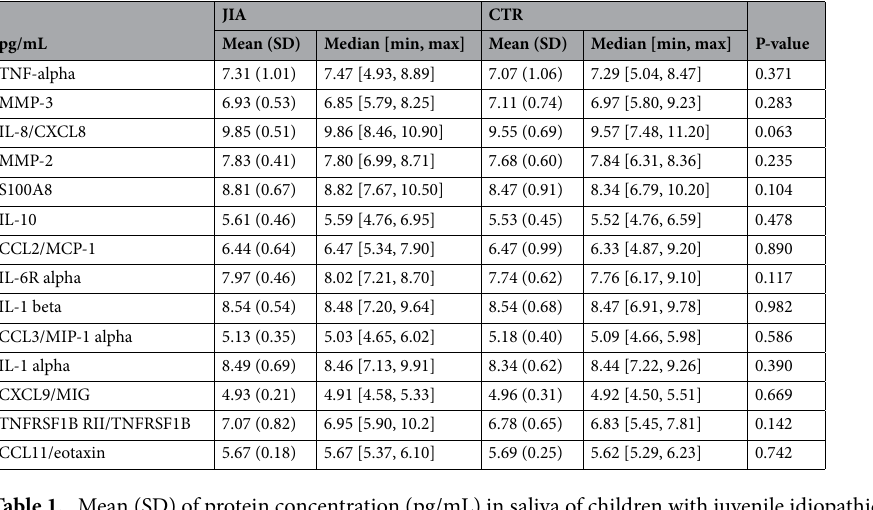
Table 1. Mean (SD) of protein concentration (pg/mL) in saliva of children with juvenile idiopathic arthritis (JIA) and healthy controls (CTR). No association was observed in the linear regression model with adjustment for age and gender (unadjusted P <